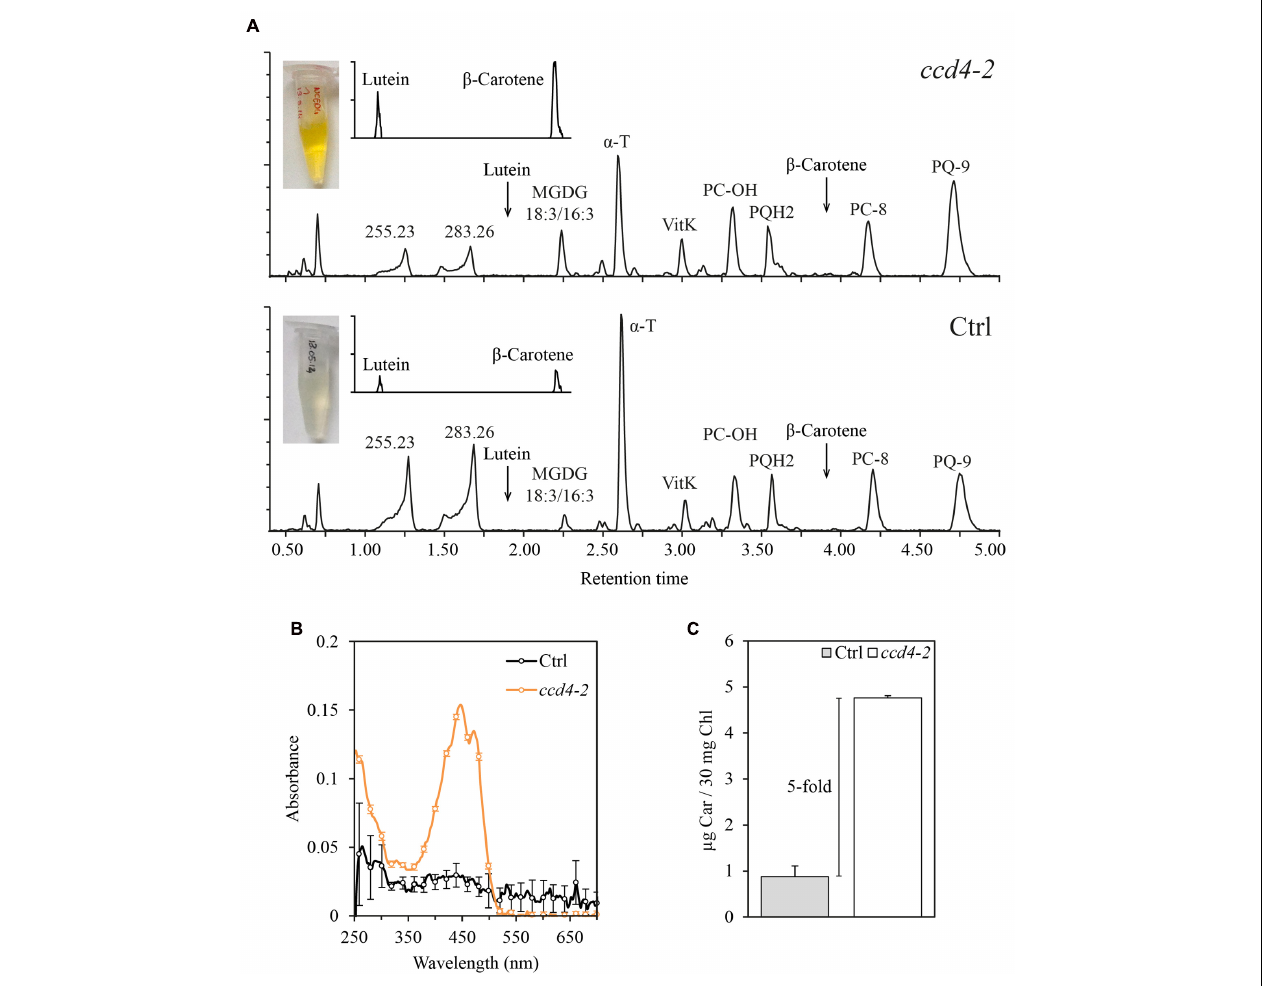
FIGURE 2 | Carotenoids accumulated in senescent plastoglobules of ccd4-2 . (A) PG were isolated from naturally senescent ccd4-2 and control plants (3 months old) by a sucrose gradient loaded with a chlorophyll-equivalent of 30 mg of membranes. Lipids from the PG fractions were analyzed by untargeted ultra-high pressure liquid chromatography-atmospheric pressure chemical ionization-quadrupole time of flight mass spectrometry and chromatograms of detected lipids are shown. (B) Spectrophotometric analysis of PG fractions. Three maxima around 450 nm, typical of carotenoid absorption spectra, were detected in ccd4-2 PG. (C) Quantification of total carotenoid contents in PG fractions. Absorbance at 448 nm was recorded and compared with a calibration curve of β -carotene standard. Carotenoid content is expressed in µ g of β -carotene per 30 mg of chlorophyll of total membranes used in the experiment.